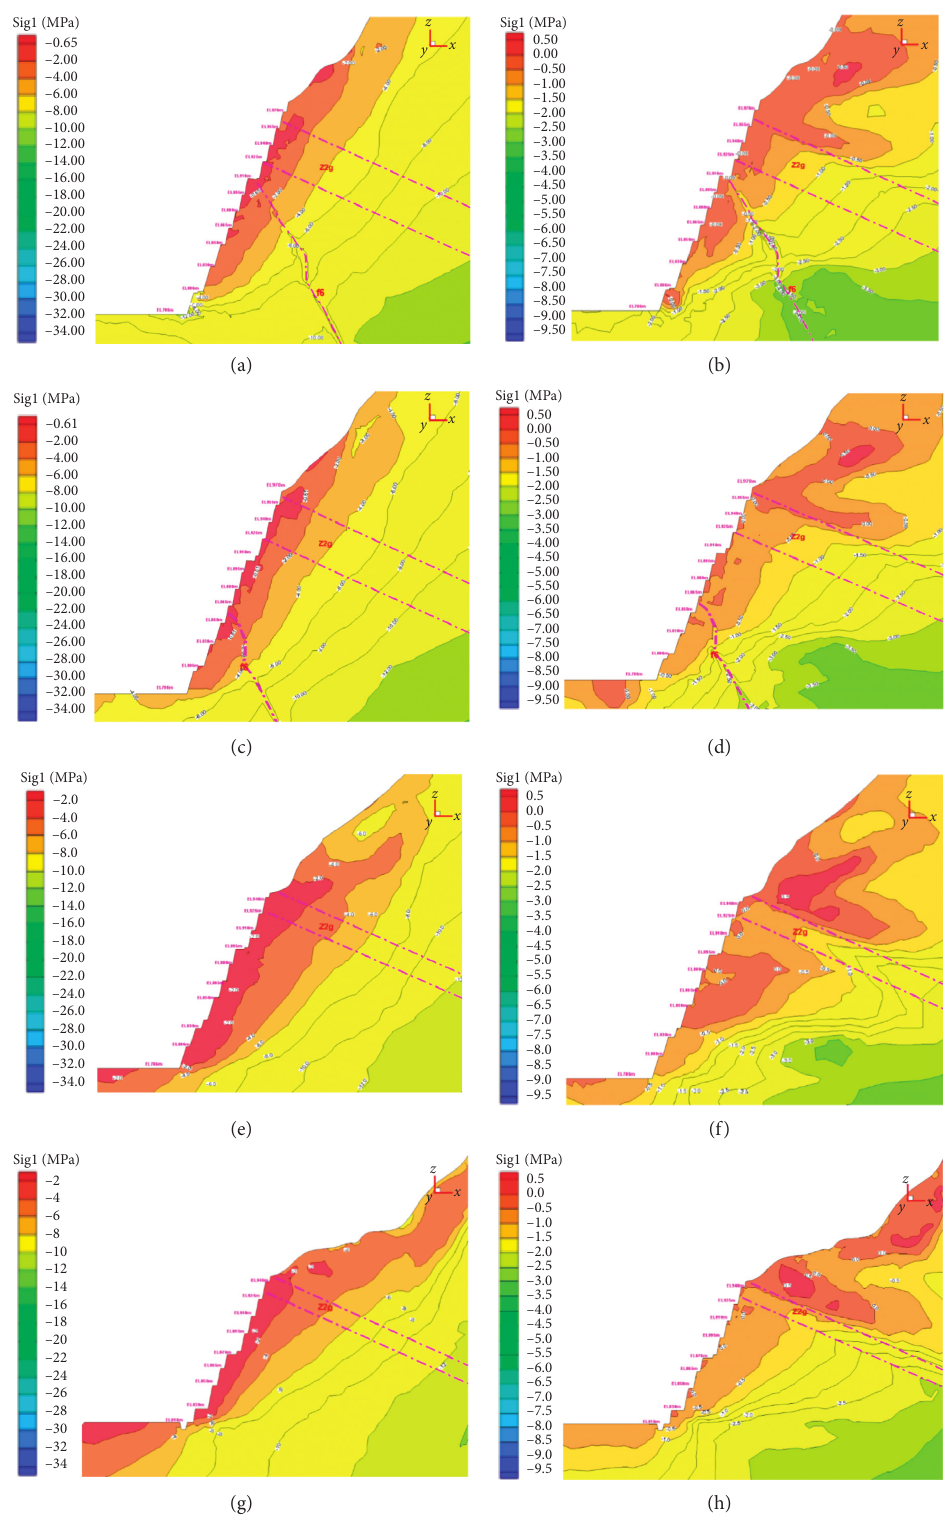
Figure 10: Cloud diagram of maximum principal stress and minimum principal stress of typical sections after excavation. (a) Cloud diagram of maximum principal stress of section 1. (b) Cloud diagram of minimum principal stress of section 2. (c) Cloud diagram of maximum principal stress of section 2. (d) Cloud diagram of minimum principal stress of section 2. (e) Cloud diagram of maximum principal stress of section 3. (f) Cloud diagram of minimum principal stress of section 3. (g) Cloud diagram of maximum principal stress of slope of section 4. (h) Cloud diagram of minimum principal stress of slope of section